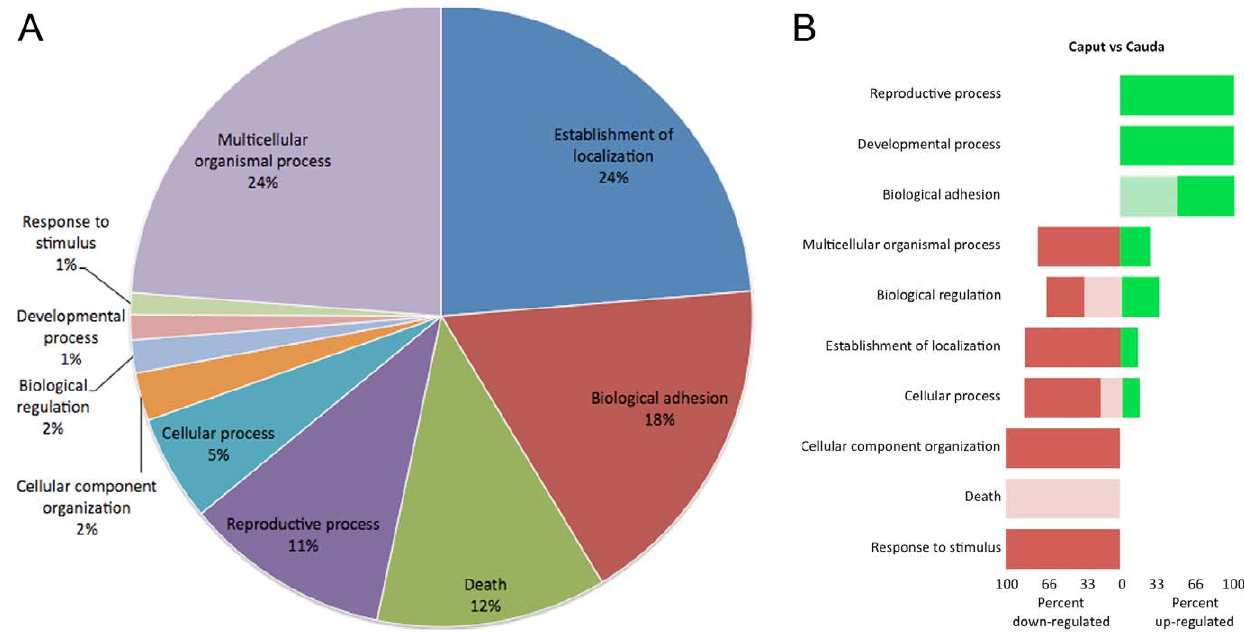
Figure 5. Categorization of predicted mRNA targets according to their GO terms. (A) Pie chart grouping predicted mRNA targets of miRNAs that significantly vary from one epididymal region to another (Fold change . 2, p value , 0.01). (B) Forest plot showing the categories of predicted mRNA targets that are significantly up or down regulated between the caput and cauda epididymidis (P value # 0.001). Light colors: miRNAs populations with a fold change ranging from 2 to 4. Dark colors: miRNAs populations with a fold change above 4.